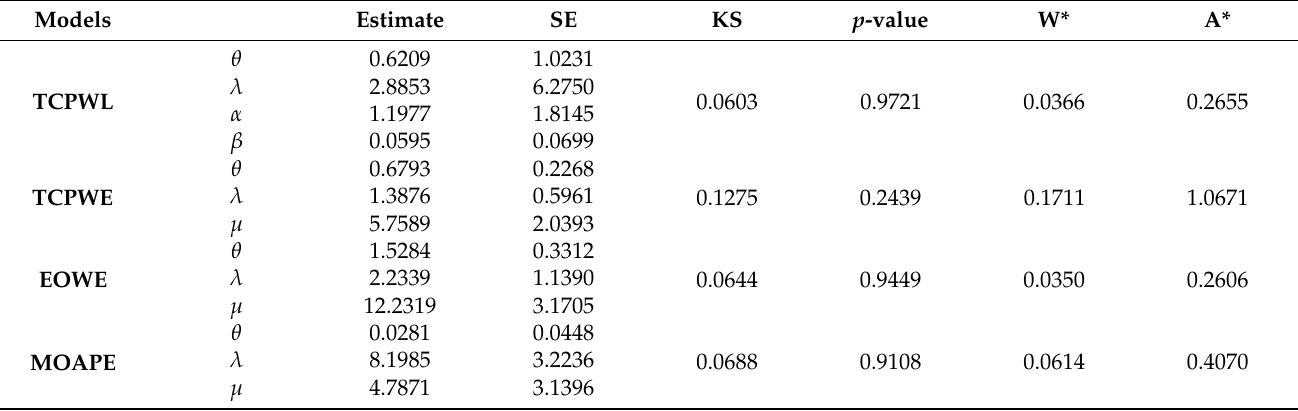
Table 6. Estimates, SE, goodness-of-fit test by using KS and different criteria measures for COVID-19